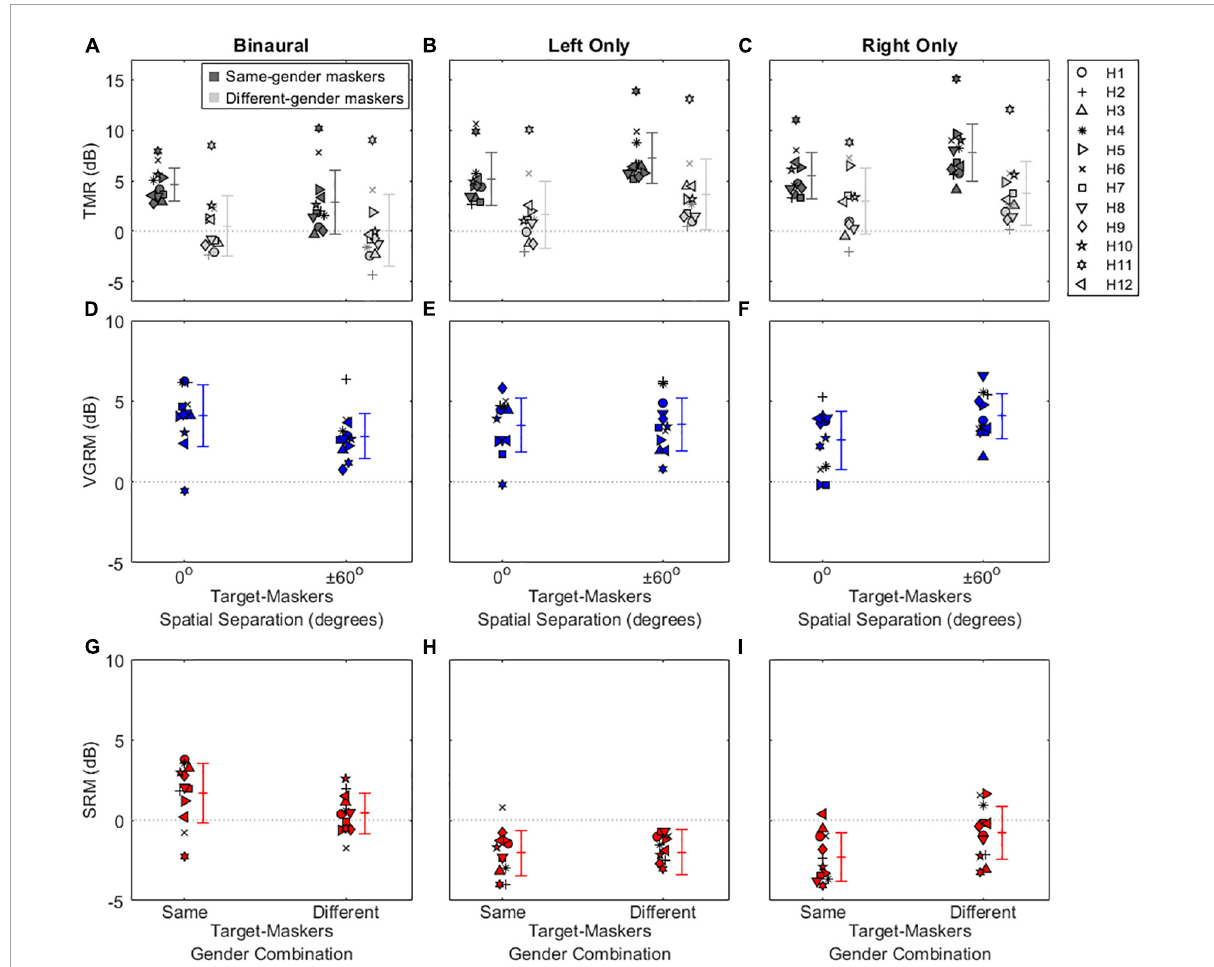
FIGURE3 Individual and average target-to-masker ratio (TMR) thresholds and voice gender release from masking (VGRM) and spatial release from masking (SRM) for bilateral HA users. Plotted as in Figure 2 , with different scales on the y -axis.